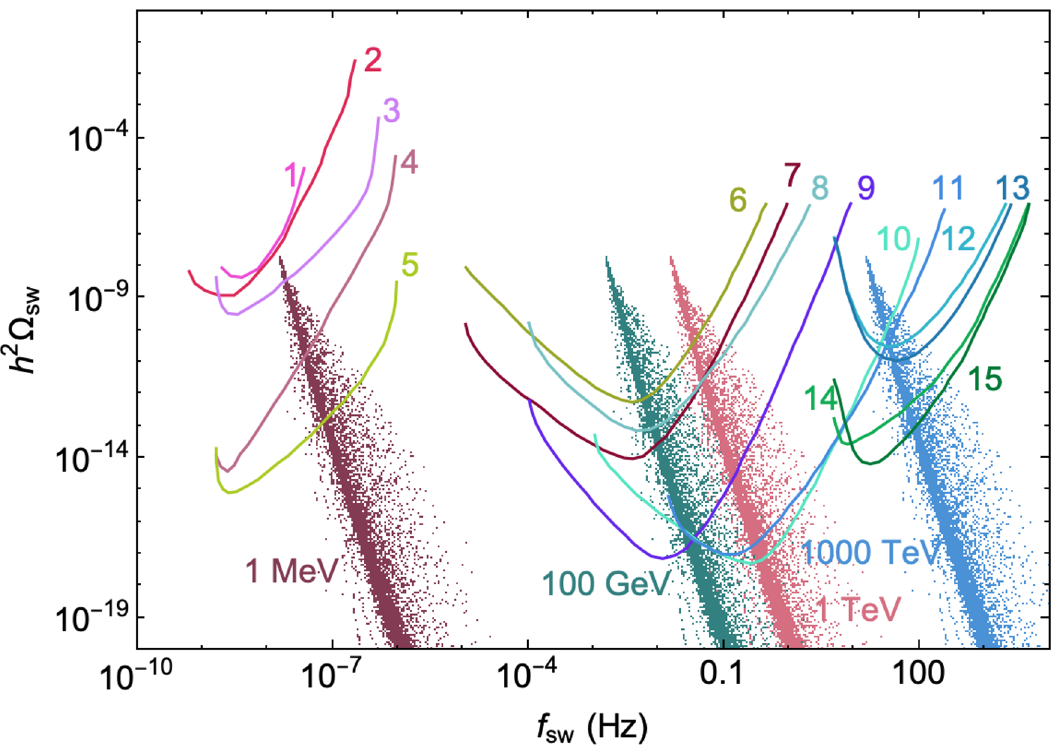
Figure 9. Plot in the ( h 2 Ω sw , f sw ) -plane of the gravitational wave signal obtained from a scan of parameter points ( b, c, Λ /v ) . The values of v used are 1 MeV, 100 GeV, 1 TeV and 1000 TeV (from left to right). Also plotted are the sensitivities of the following current and upcoming